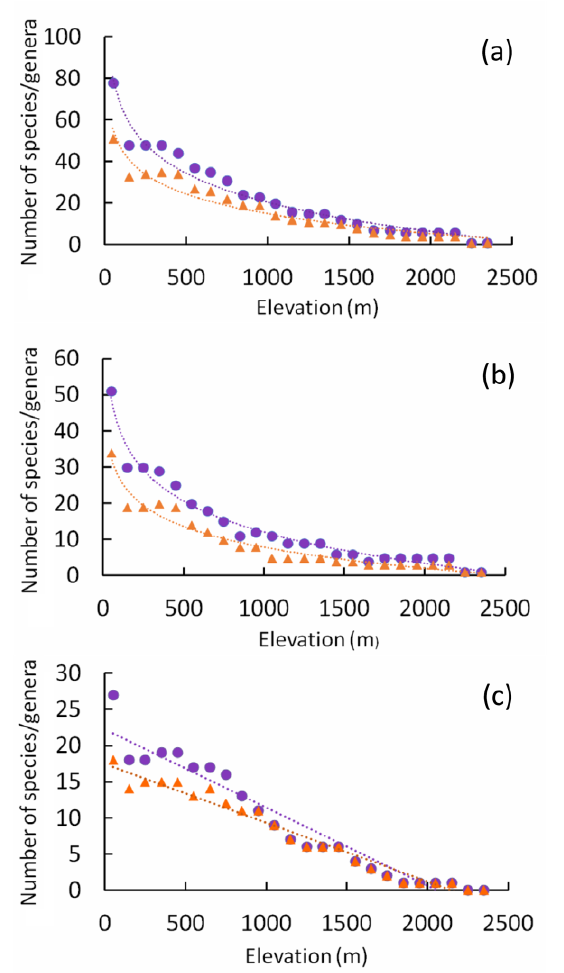
Figure 1. Relationships of number of tenebrionid species (purple circles) and genera (orange triangles) with elevation (in meters) calculated for all species ( a ), geophilous species ( b ), and xylophilous species ( c ). Dotted lines are regression lines. Regression models were semilog functions for panels ( a ) and ( b ), and linear functions for panel ( c ). Regression equations and goodness-of fit values are given in Table 1.